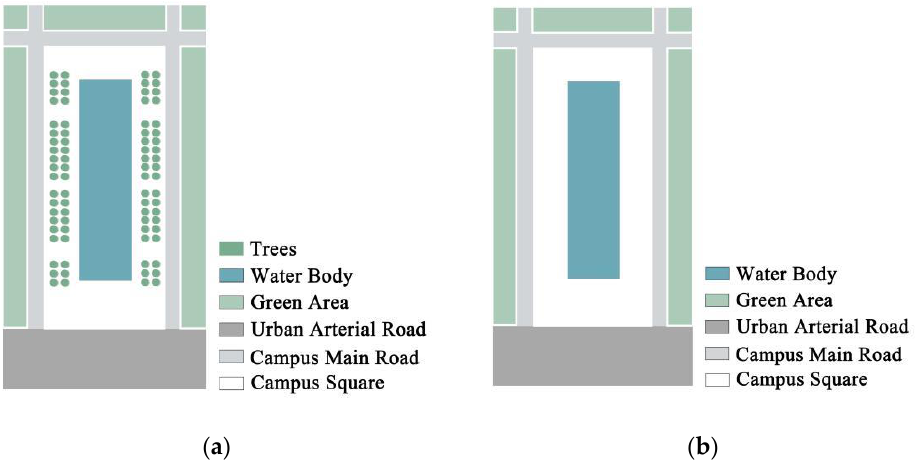
Figure 3. Theoretical model of the campus square: ( a ) with-tree model; ( b ) without-tree model.